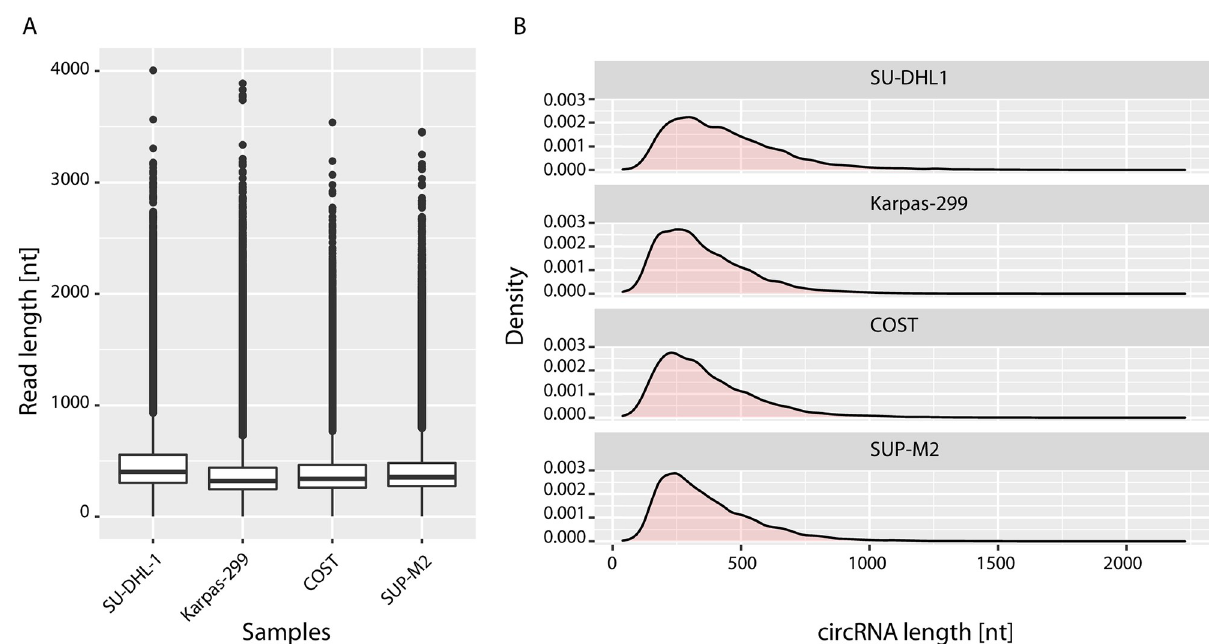
Fig 3. Distribution of the length of identified circRNAs. Shown are the results of circRNA sequencing from 4 anaplastic large-cell lymphoma (ALCL) cell lines with Oxford Nanopore. A) Distribution of read length and B) length of the identified circRNAs in the 4 different ALCL cell line samples. Gaussian kernel density estimation was used to calculate the distribution of circRNA